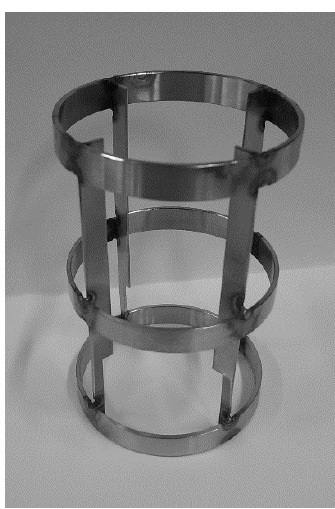
Figure 6. Used flow breaker for the optimization of the reaction